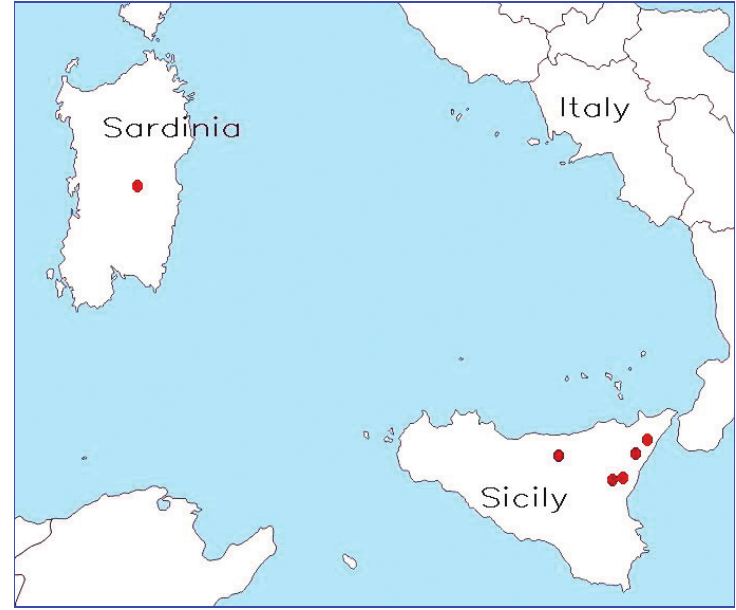
Figure 6. Map of distribution of Bucculatrix brunnella sp.